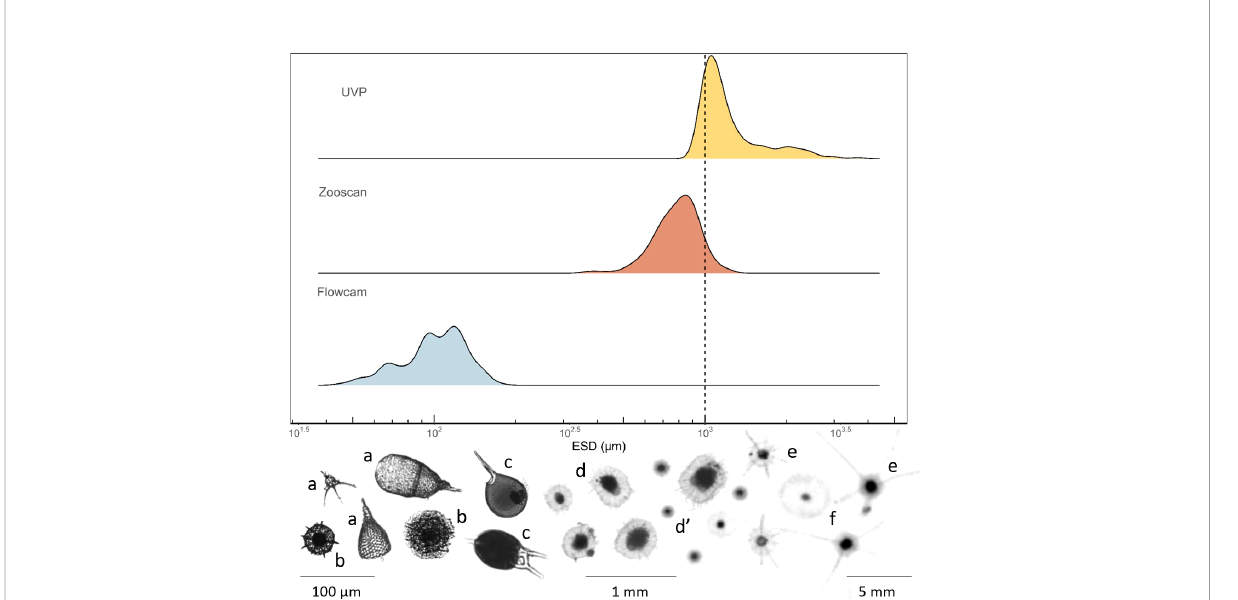
FIGURE 2 Density plot comparing the total size range of Rhizaria (in equivalent spherical diameter; ESD) captured by the three imaging tools used in this study (FlowCAM, Zooscan and UVP). The area under the curve represents the probability of getting an x value between a range of x values. The dashed line represents the upper limit of the Zooscan data considered and the lower limit of the UVP data, which was established to avoid overlap between these two instruments. (A) FlowCam images of Nassellaria, (B) Spumellaria, (C) FlowCam images of phaeodarians of the family Challengeridae, (D, D ’ ) Zooscan and UVP images of phaeodarians of the family Aulacanthidae respectively, (E) UVP images of phaeodarians of the family Coelodendridae and, (F) UVP images of phaeodarians of the family Aulosphaeridae.